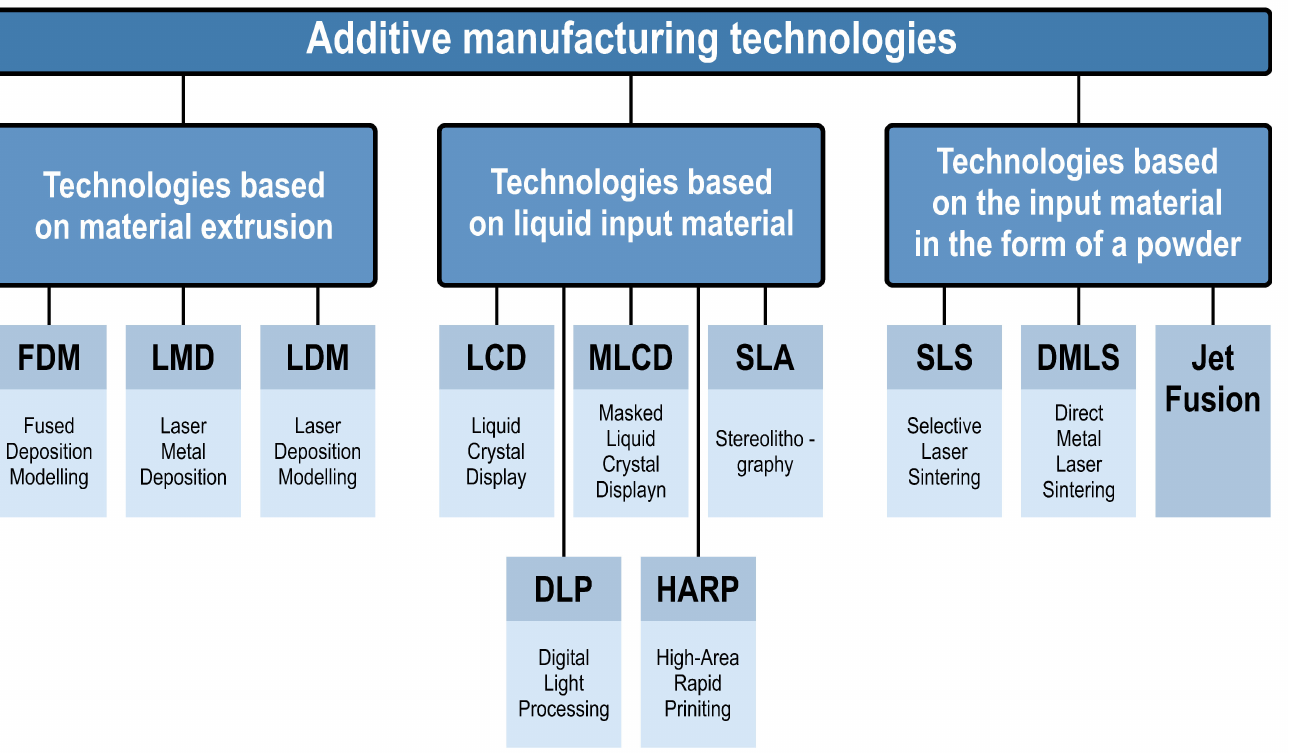
Figure 2. Division of additive manufacturing methods (own elaboration, based on [3–5,8]).